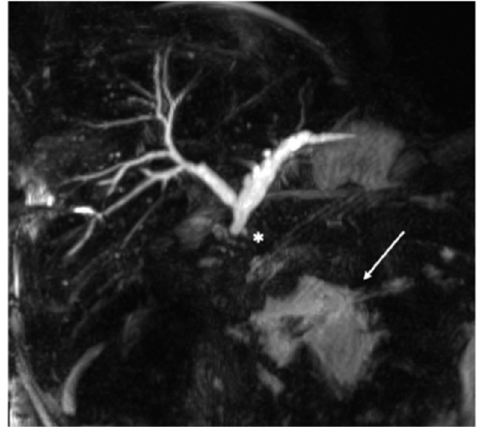
Figure 2. MRCP exam revealing a stenosis (*) of the HJS with a collection near the hepatic hilum (arrow).